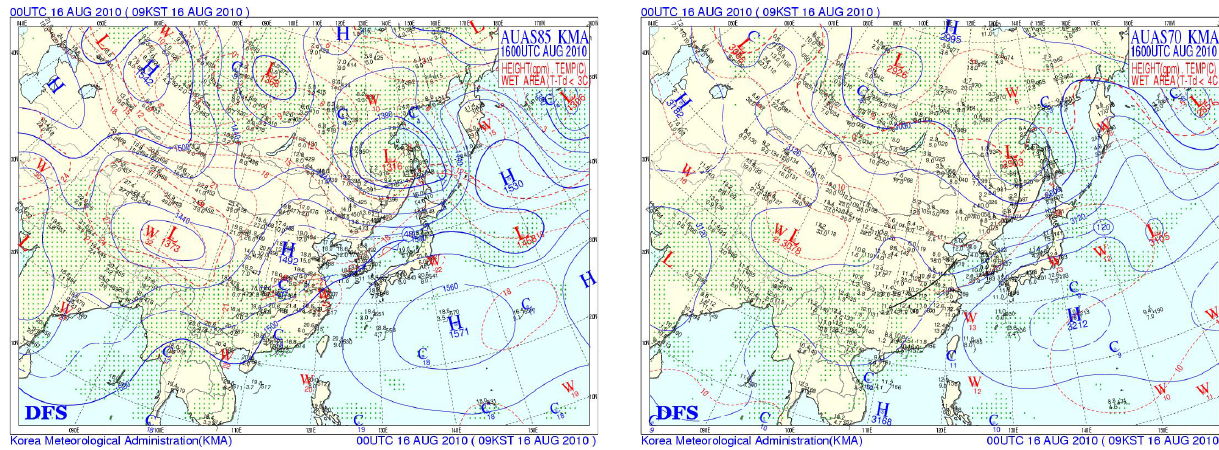
Fig. 3. Weather patterns at 850hpa (left) and 700hpa (right) over the eastern Asia at 8:00a.m. on 16 August 2010 (from Korea Meteorological